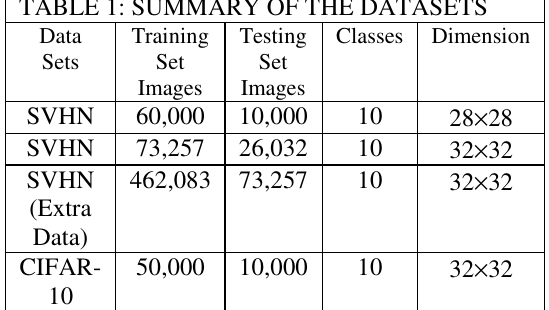
TABLE 1: SUMMARY OF THE DATASETS